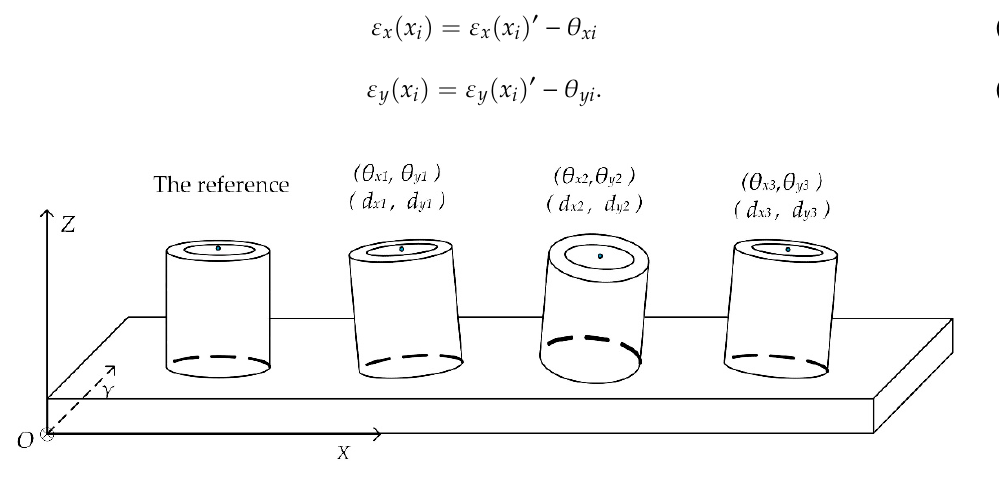
Figure 7. Implementation of large-scale measurement.